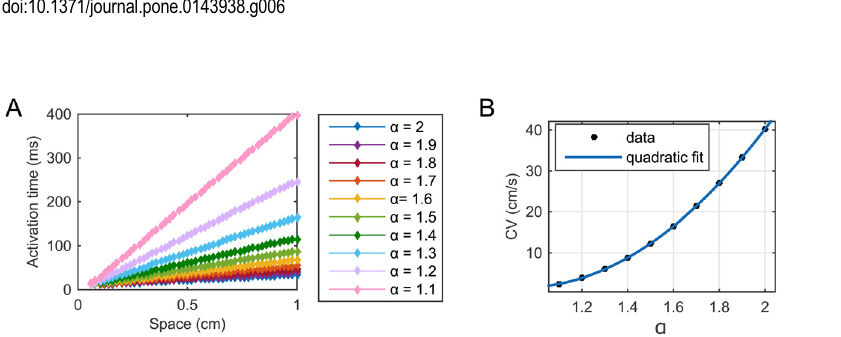
Fig 7. Activation time of forty-eight equally spaced nodes in the spatial domain [0.06 cm, 1 cm] and conduction velocity for ten different values of α . The CV corresponding to the reciprocal of the gradient of each of the ten straight lines in (A) was considered as data in (B) and a quadratic dependence of these data points from the fractional order α was